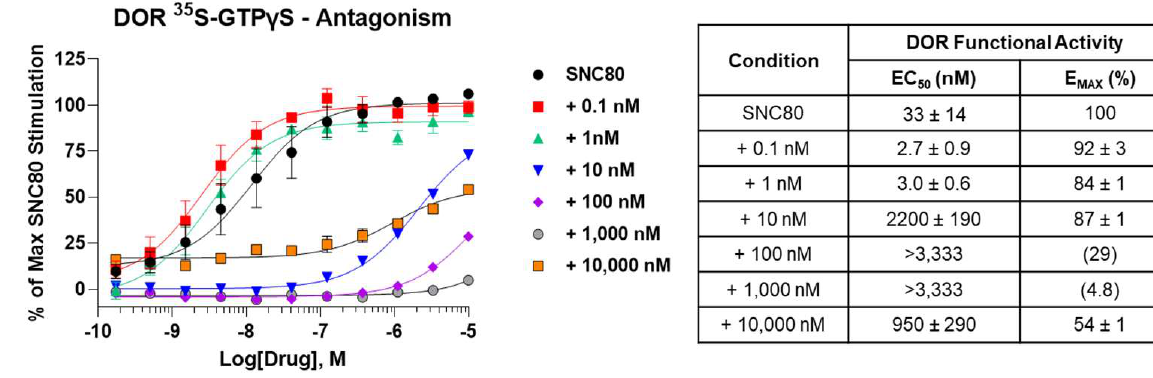
Figure 2. SRI-9342 displayed DOR irreversible antagonism at low concentrations. SNC80 is a full DOR agonist, which was used to perform multiple full concentration curves using the 35 S-GTP γ S assay (see Methods). Increasingly large fixed concentrations of SRI-9342 were included in subsequent SNC80 curves. N = 3 independent experiments performed, with summary curves shown. Potency (EC 50 ) and efficacy (E MAX ) were calculated separately for each experiment and reported as the mean SEM. SRI-9342 caused increasing loss of efficacy at 0.1 and 1 nM without decreasing potency (which was actually higher than SNC80 alone), suggesting irreversible antagonism. Beginning at 10 nM, potency loss was observed, which could indicate mixed activity or a very strong loss of receptors from the receptor pool due to irreversible antagonist activity.